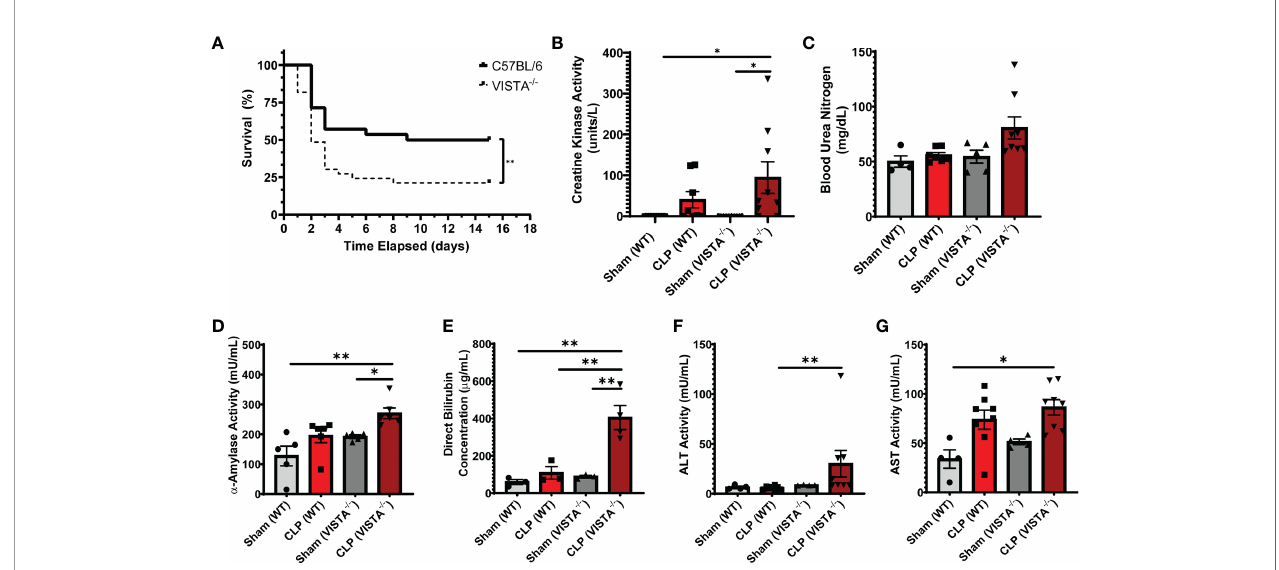
FIGURE 8 | VISTA -/- mice have signi fi cantly worse survival and morbidities following septic challenge. (A) 14-day survival following CLP [WT: n = 28 , VISTA -/- : n = 26 ]. (B) Creatine kinase activity [WT-sham: n = 9 , WT-CLP: n = 9 , VISTA -/- sham: n = 10 , VISTA -/- -CLP: n = 10 ]. (C) blood urea nitrogen [WT-sham: n = 4 , WT-CLP: n = 9 , VISTA -/- sham: n = 5 , VISTA -/- -CLP: n = 8 ]. (D) a -Amylase activity [WT-sham: n = 5 , WT-CLP: n = 6 , VISTA -/- sham: n = 5 , VISTA -/- -CLP: n = 6 ]. (E) Direct bilirubin concentration [WT-sham: n = 3 , WT-CLP: n = 3 , VISTA -/- sham: n = 3 , VISTA -/- -CLP: n = 4 ]. (F) alanine aminotransferase activity [WT-sham: n = 4 , WT-CLP: n = 8 , VISTA -/- sham: n = 4 , VISTA -/- -CLP: n = 8 ]. (G) Aspartate aminotransferase activity [WT-sham: n = 4 , WT-CLP: n = 8 , VISTA -/- sham: n = 4 , VISTA -/- -CLP: n = 8 ] from plasma samples of wild-type and VISTA -/- mice. (B – G) Summary graphs show mean ± SEM; signi fi cance *p < 0.05; **p < 0.01.